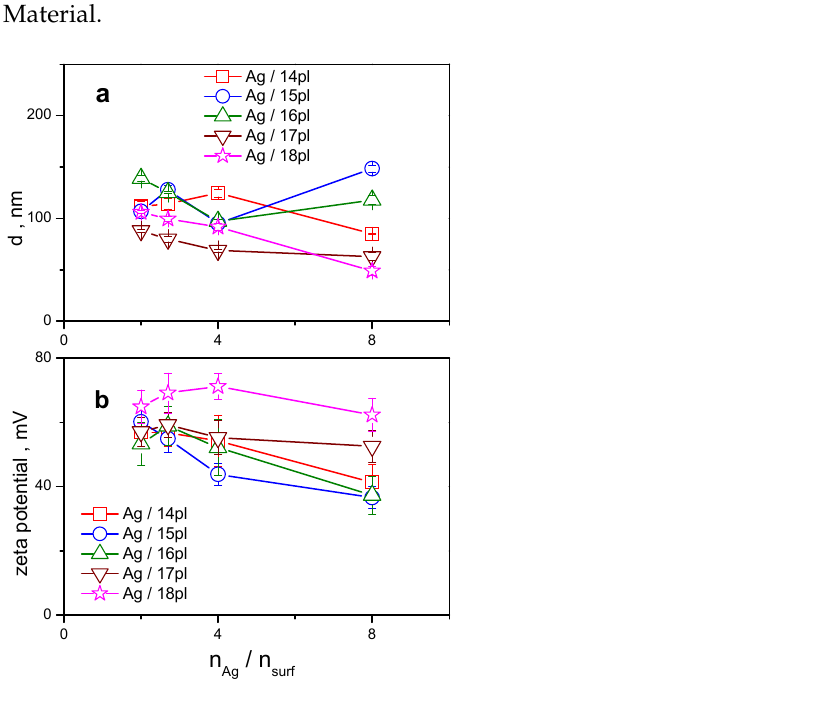
Figure 3. ( a ): Hydrodynamic size d of silver nanoparticles stabilized with phospholium surfactants 14pl – 18pl plotted against n Ag /n surf . ( b ): zeta potential plotted against n Ag /n surf . Hydrodynamic size of AgNPs stabilized with phospholium surfactants varies in the range 49–149 nm. For all investigated surfactants, the size of AgNPs increases with in- creasing the amount of surfactant in nanodispersion (right-to-left direction in the plot) below n Ag /n surf = 4. This indicates the formation of protective surfactant bilayer surround- ing the nanoparticle. The dependence of AgNPs size on the alkyl chain length of phos- pholium surfactants results from the plot in Figure 3a, as well. This dependence is most obvious at the largest silver-to-surfactant molar ratio value and for long-chain homologs 17pl and 18pl that provide intense stabilizing effect to AgNPs even at the lowest amount of surfactant in Ag nanodispersion. The size of Ag/ 17pl and Ag/ 18pl nanoparticles is still well below 70 nm. The size of AgNPs stabilized with pl surfactants of a shorter alkyl chain length (14, 15, 16 carbon atoms) is significantly larger at this molar ratio. This indicates the importance of alkyl chain length factor in the process of the formation of stable AgNPs with a small size. When increasing surfactant amount in Ag nanodispersion, the AgNP size moderately increases. At small n Ag /n surf values, the differences in AgNP size disappear and the AgNP size seems to converge to the size values somewhere between 100–110 nm. The insufficient alkyl chain length that produces less stable AgNPs with large size, is com- pensated to a certain extent by increasing the amount of short-chain surfactant in Ag nano- dispersion. A similar trend to that observed for the AgNP hydrodynamic size dependence on n Ag /n surf molar ratio is also observed for the zeta potential changes as a function of the silver-to-surfactant molar ratio (Figure 3b). Zeta potential of AgNPs stabilized by all in- vestigated surfactants is found to be positive enough (above +40 mV) which indicates good stabilizing effect of phospholium surfactants on AgNPs. Similarly, zeta potential in- creases with the increasing surfactant amount which is to relate to the increased stability of Ag nanodispersions because of the presence of surfactant molecules. The largest stabi- lizing effect on AgNPs is attained by the long-chain surfactant 18pl with high positive zeta values between +64 and +72 mV in the whole range of molar ratio values. The zeta values as a function of surfactant alkyl chain length are more scattered at large n Ag /n surf values. The dependence on the alkyl chain length is diminished as n Ag /n surf decreases towards small values, thus making nanodispersions more stable by the presence of larger surfac- tant amount. This effect is like that observed in Figure 3a.